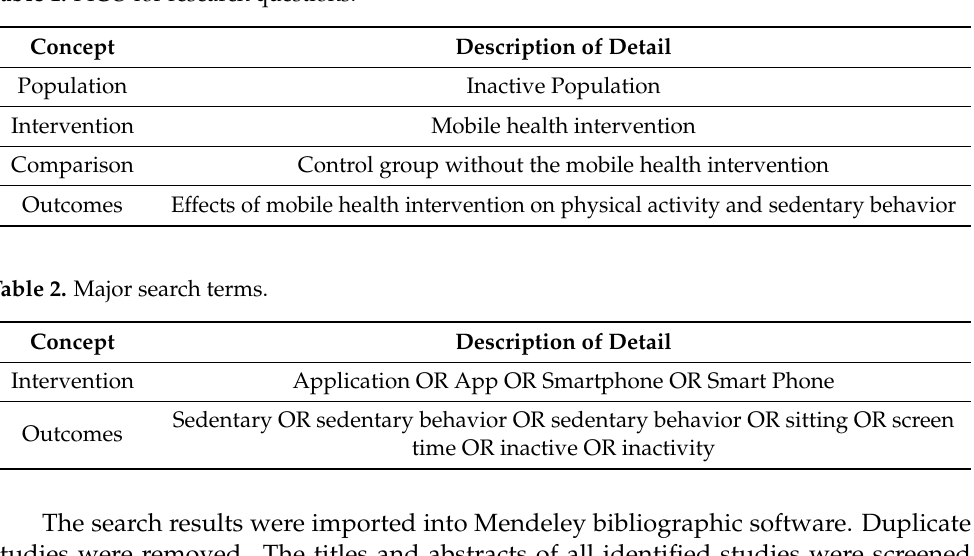
Table 1. PICO for research questions.